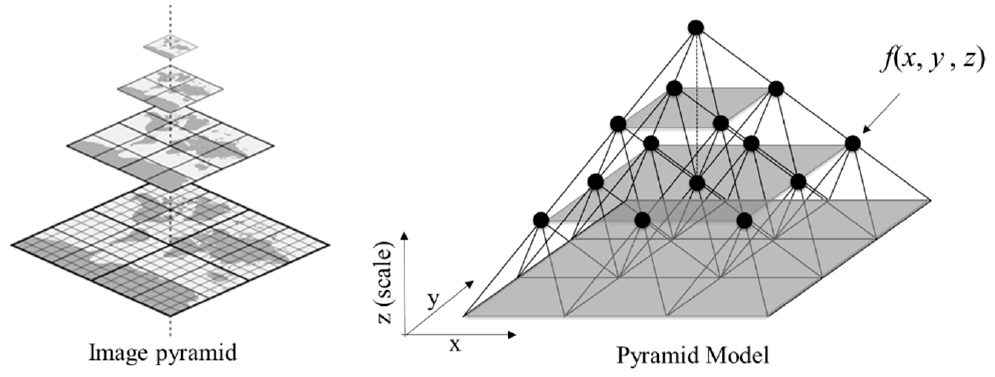
Figure 14. Illustration of an image pyramid ( left ) and the configuration of the pyramid model for a raster ( right ).